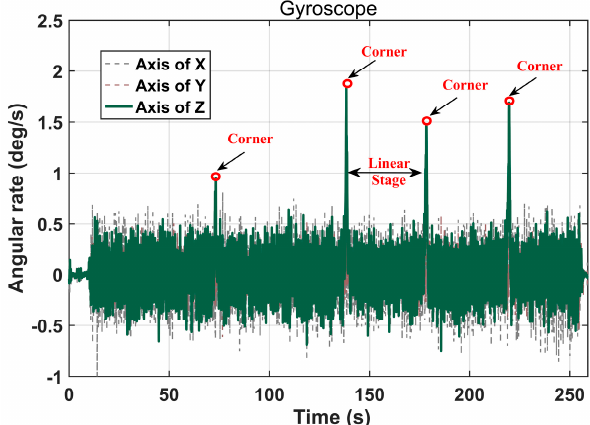
Figure 8. Data of gyroscope in handheld attitude.